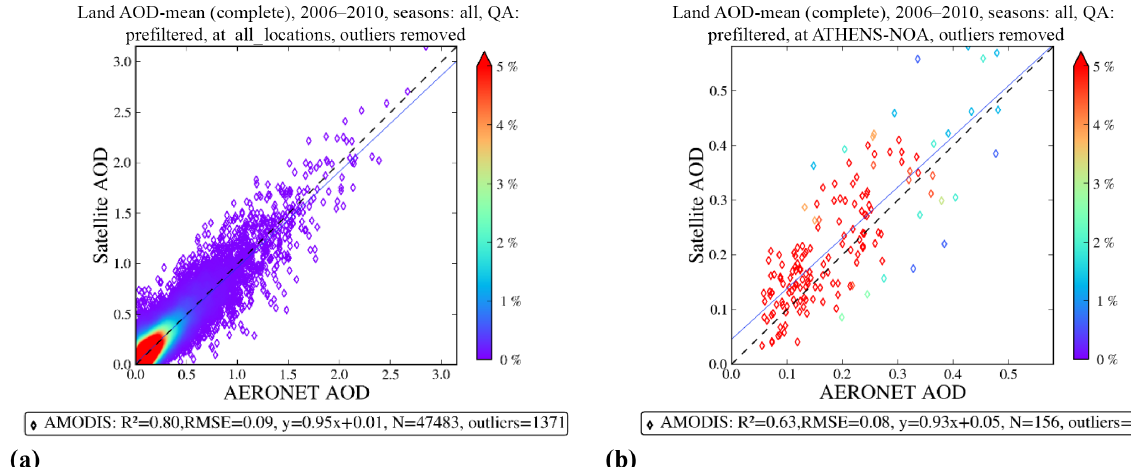
Figure 4. Scatter plots of satellite AOD (550nm) from MODIS/Aqua vs. coincident AOD from AERONET for the 5-year period 2006–2010 with outliers removed. Panel (a) shows the global record and (b) is for the ATHENS-NOA site. The colour bar describes the percentage frequency of AOD values occurrence (source of the plots: